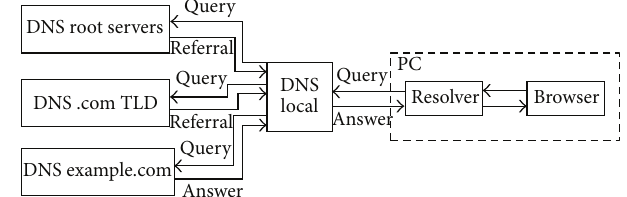
Figure 2: Recursive query